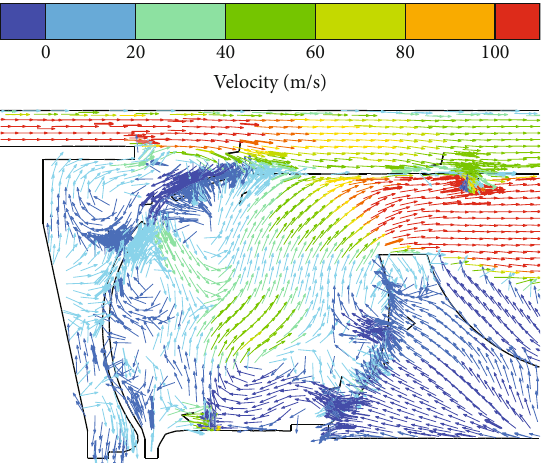
Figure 10: Nonreacting fl ow computational results at two sections with optimized geometry at 80% design